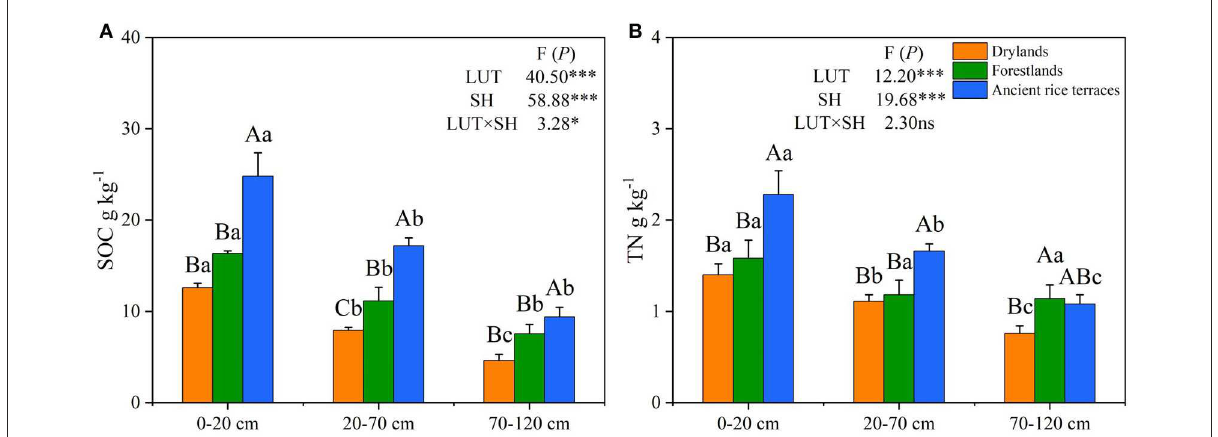
FIGURE2 (A,B) SOC and TN contents of three land use types in different soil horizons. SOC, soil organic carbon; TN, total nitrogen; LUT, land use types; SH, soil horizons. Various capital letters stand for significant differences among diverse land use types, diverse lower-case letters indicate significant differences among diverse soil horizons. * p < 0.05; *** p < 0.001; ns not